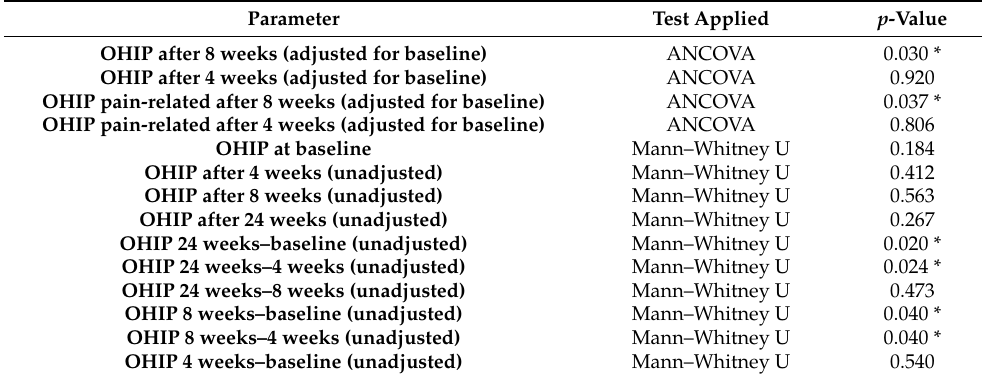
Table 5. Comparison of the OHIP-49 scores, statistical tests, and corresponding p